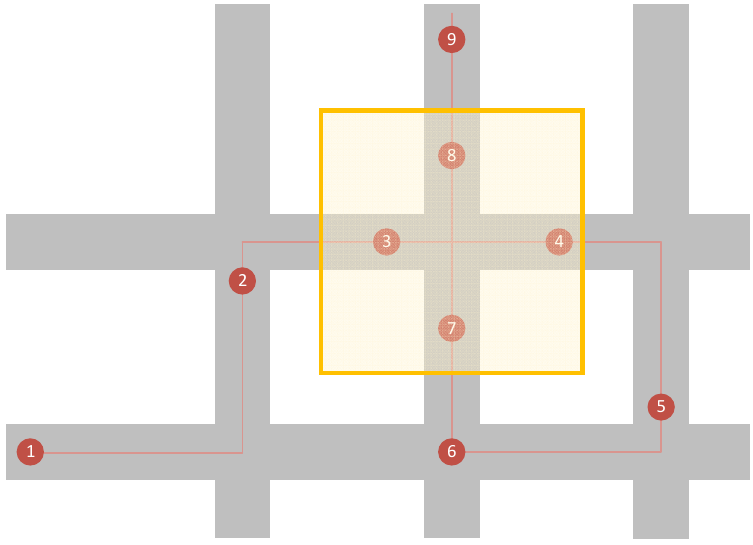
Figure 8. Diagram showing the geofence (yellow area) implementation.